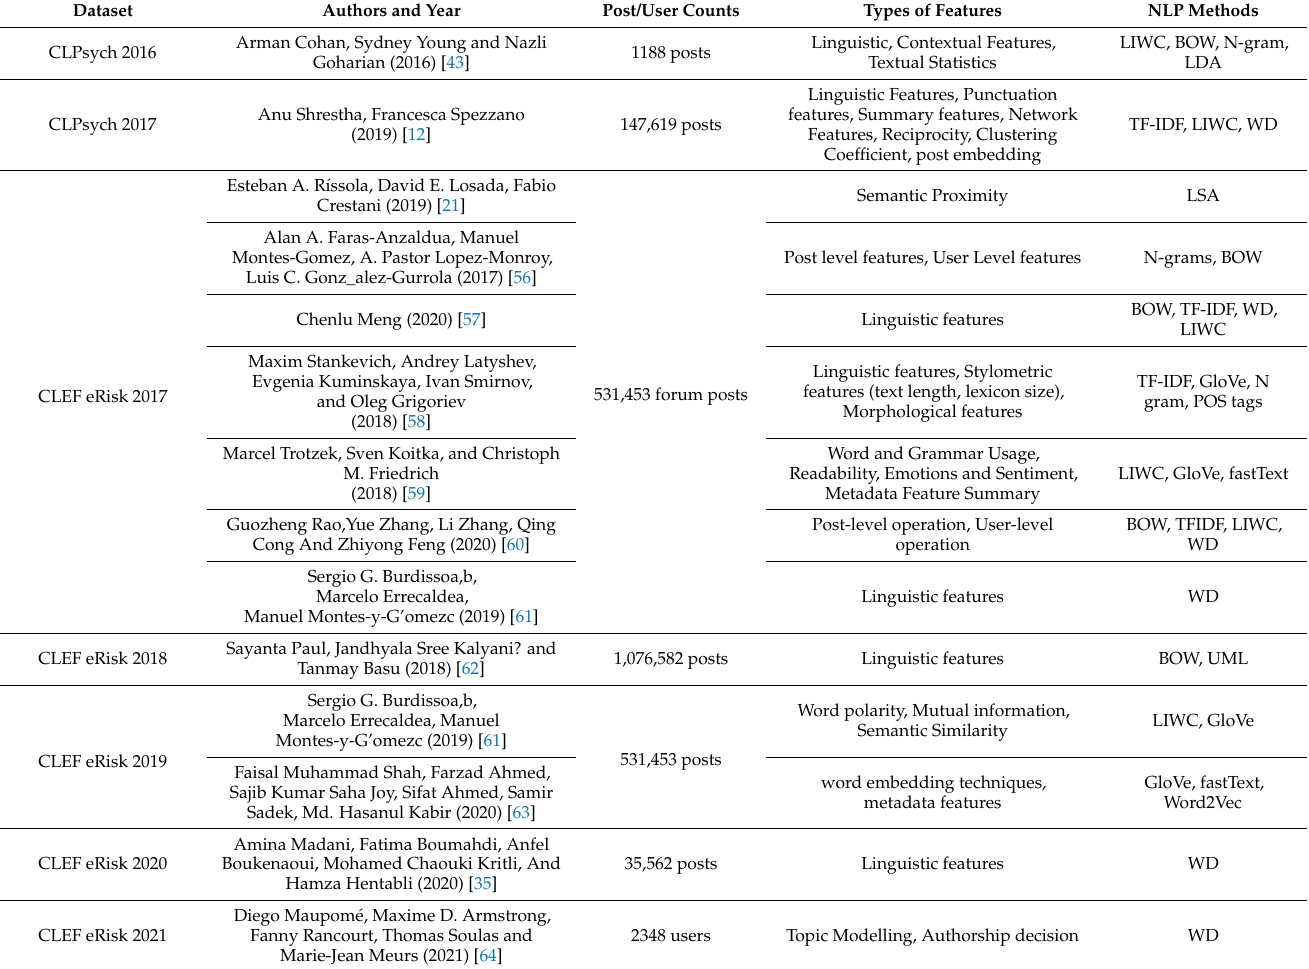
Table 1. Summary of the datasets, feature types and NLP methods used in previous studies (Bag Of Words = BOW, Term Frequency/Inverse Term Frequency = TF-IDF, Part Of Speech = POS, Linguistic Inquiry Word Count = LIWC, Latent Semantic Analysis = LSA, Latent Dirichlet Analysis = LDA, Word Embedding = WD, Global Vectors Embedding = Glove, fastText Embedding = fastText, Word to Vector Embedding = Word2Vec, type-token ratio = TTR, Brunet’s Index = BI, Honore’s Statistics =